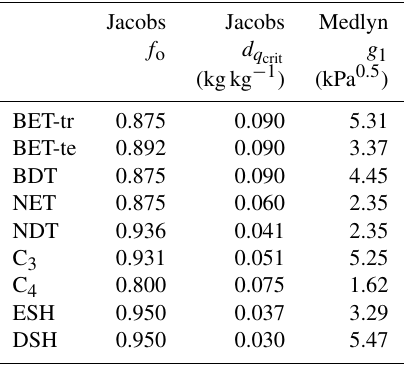
Table 3. PFT-specific parameters required for the Jacobs and Med- lyn g s schemes. Jacobs Jacobs